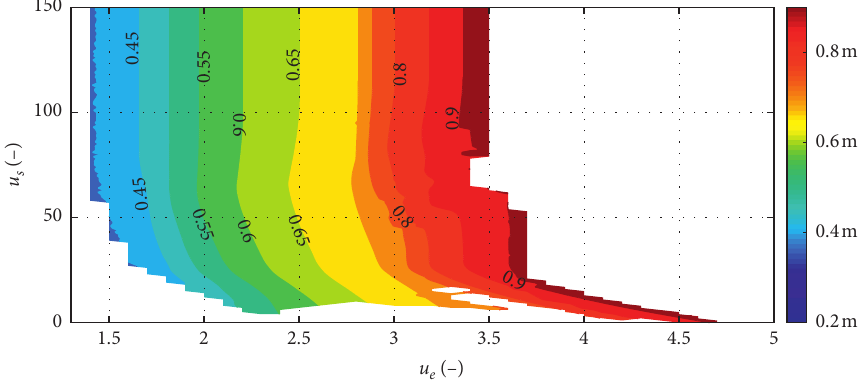
Figure 6: Step length as a function of the control parameters ( u